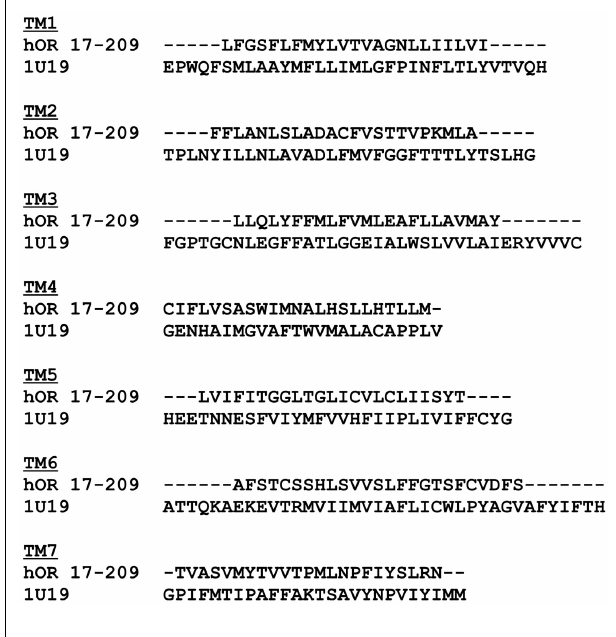
FIGURE 3 | hOR17-209TM prediction results and structural alignments against theTMs in Bovine Rhodopsin (PDB: